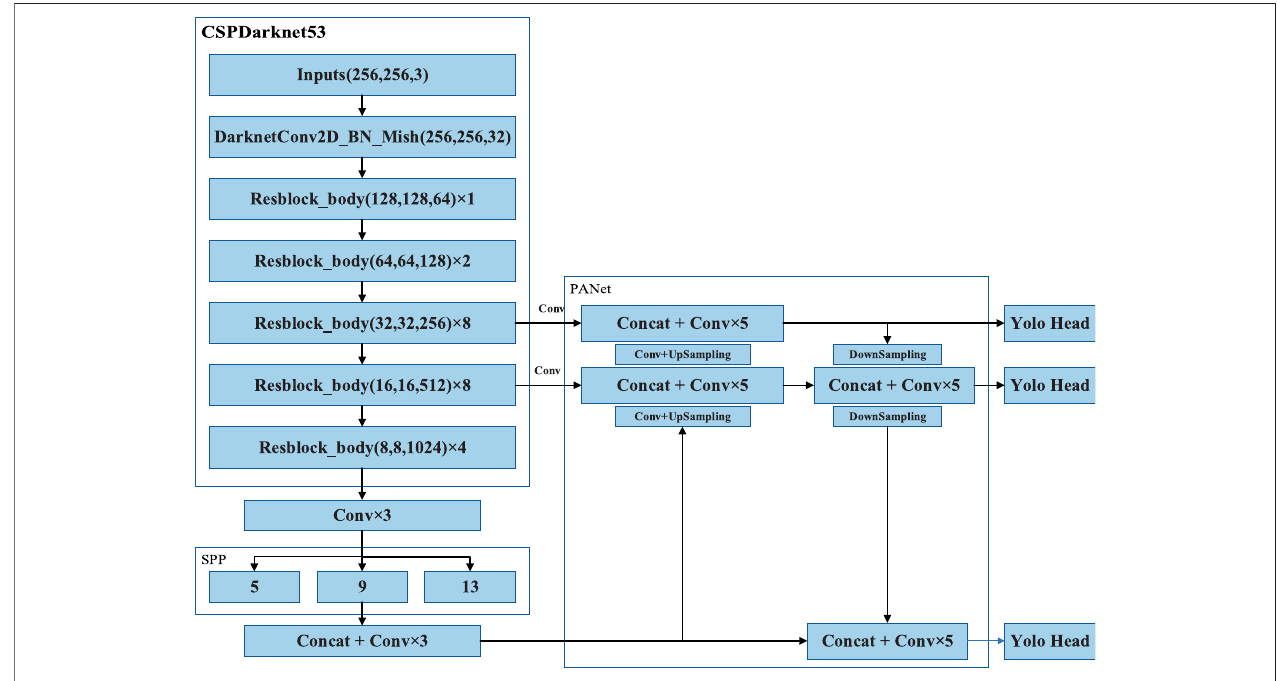
FIGURE 1 | YOLOv4 network architecture.